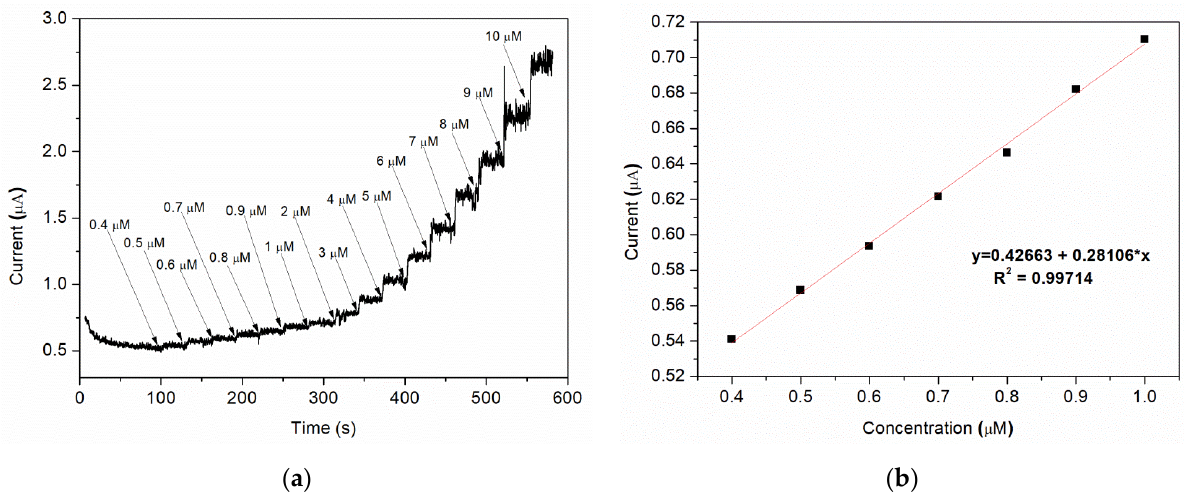
Figure 9. ( a ) Amperometric response of various nitrite concentration; ( b ) corresponding plot of peak current vs. nitrite concentration (linear calibration plot).